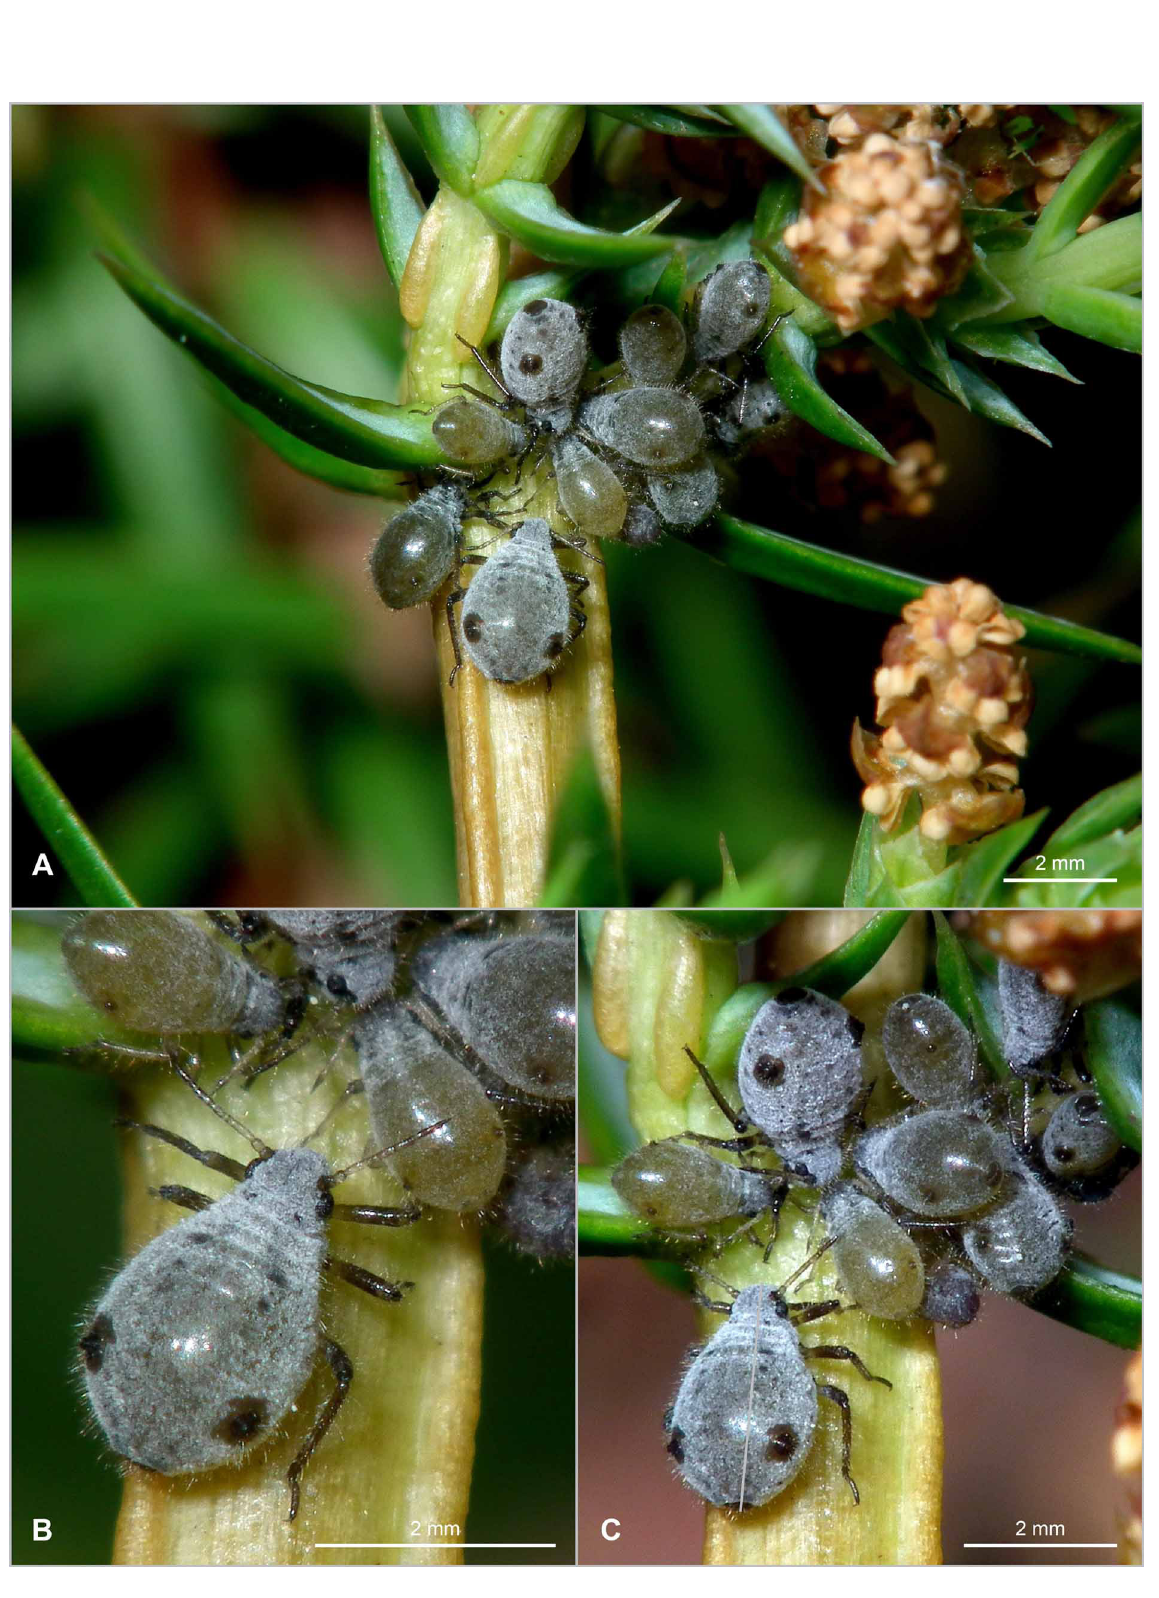
Fig. 116. Cinara (Cupressobium) mordvilkoi (Pasek, 1954). Colonies on current year’s twigs of Juniperus